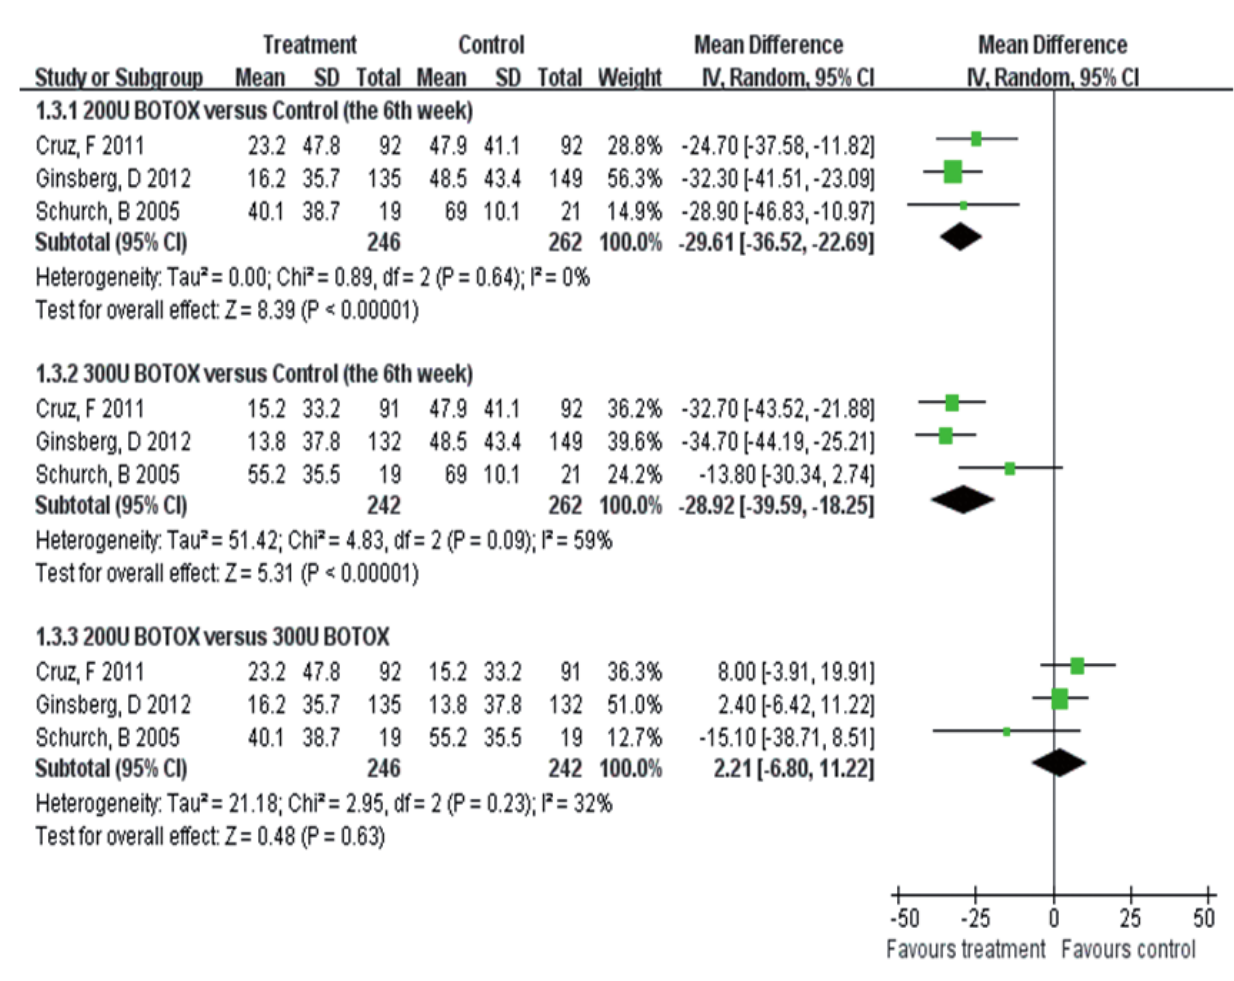
Figure 4 - Forest plot for the outcome of maximum detrusor pressure